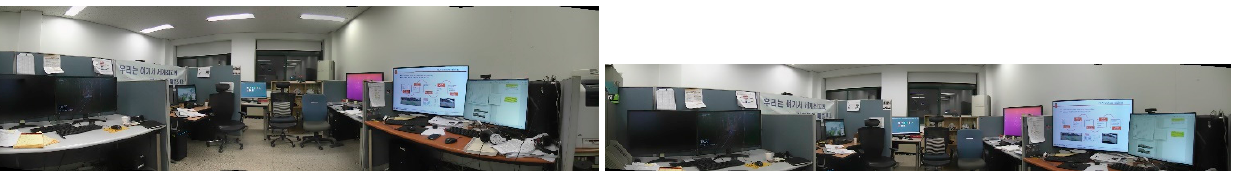
Figure 14. Twenty unstitched images of panorama from center of room (each image is originally captured in 1920 × 1080 resolution).